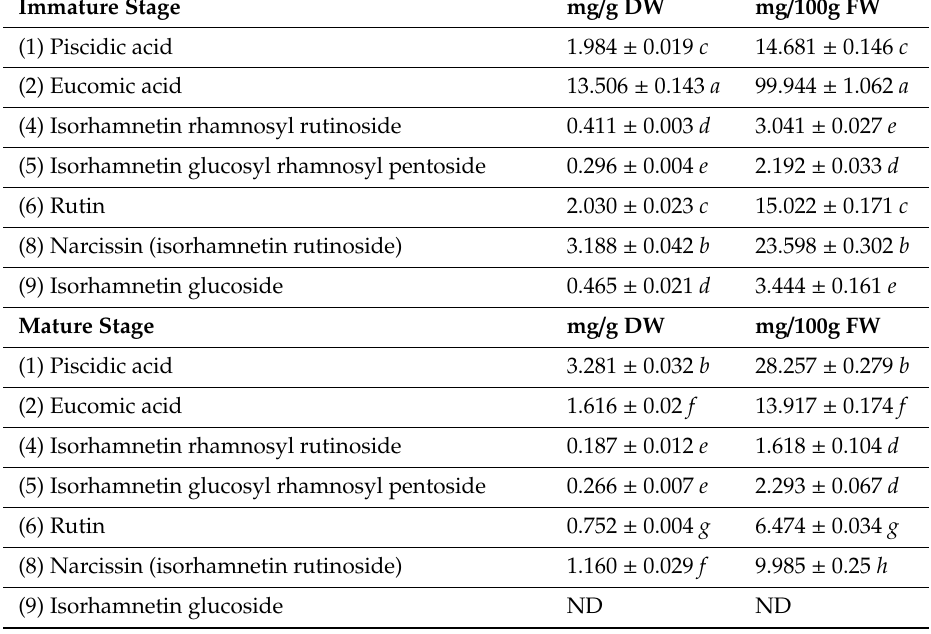
Table 2. Phenolic acids and flavonols content of Opuntia ficus-indica extracts, from immature and mature cladodes. Phenolic acids were quantified using the calibration curve of p -hydroxybenzoic acid. Flavonols were determined using calibration curves with the closest appropriate standard (rutin, isorhamnetin glucoside or isorhamnetin rutinoside). Mean values ( n = 3) ± standard deviation (SD) are expressed as dry weight (DW) or fresh weight (FW). The same letters ( a–h ) in the column indicate that mean values are not significantly di ff erent ( p <